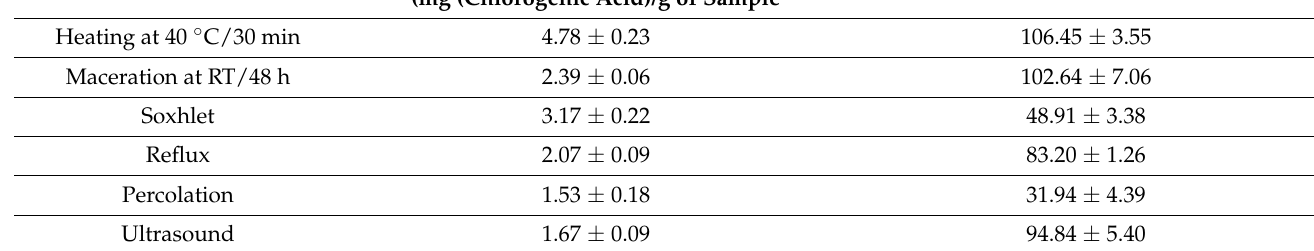
Table 1. Comparison of the methanol extraction methods of ground and sieved pellets (GSP) sample. Total Phenolic Compounds (TPC) by Individual Phenolic Compounds by HPLC Methods of Extraction Colorimetric Method Folin–Ciocalteu Reagent) ( µ g (Chlorogenic Acid)/g of Sample) (mg (Chlorogenic Acid)/g of Sample Heating at 40 ◦ C/30 min 4.78 ±